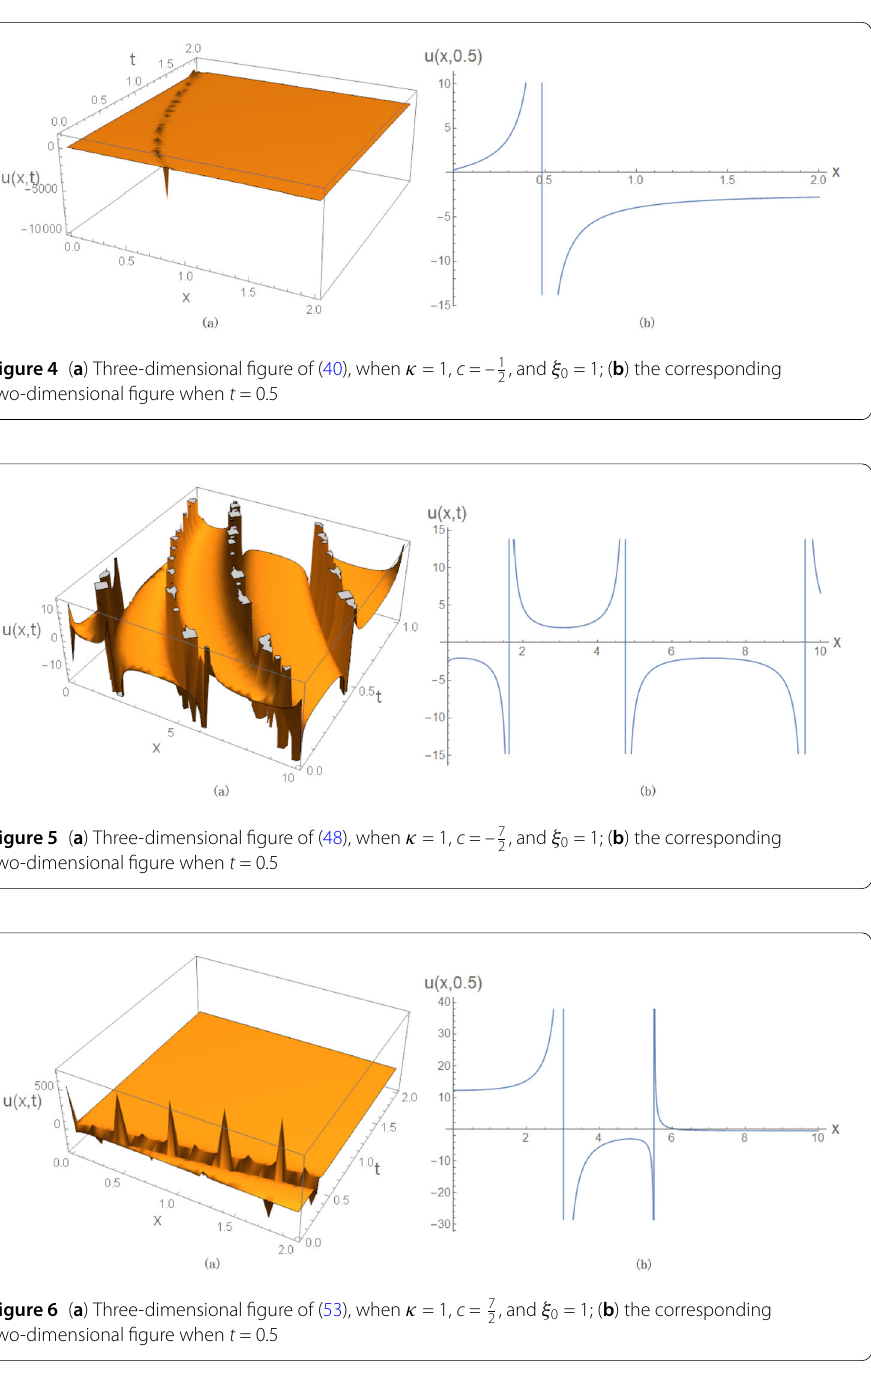
Case 8. For α = 0.7 (Fig.